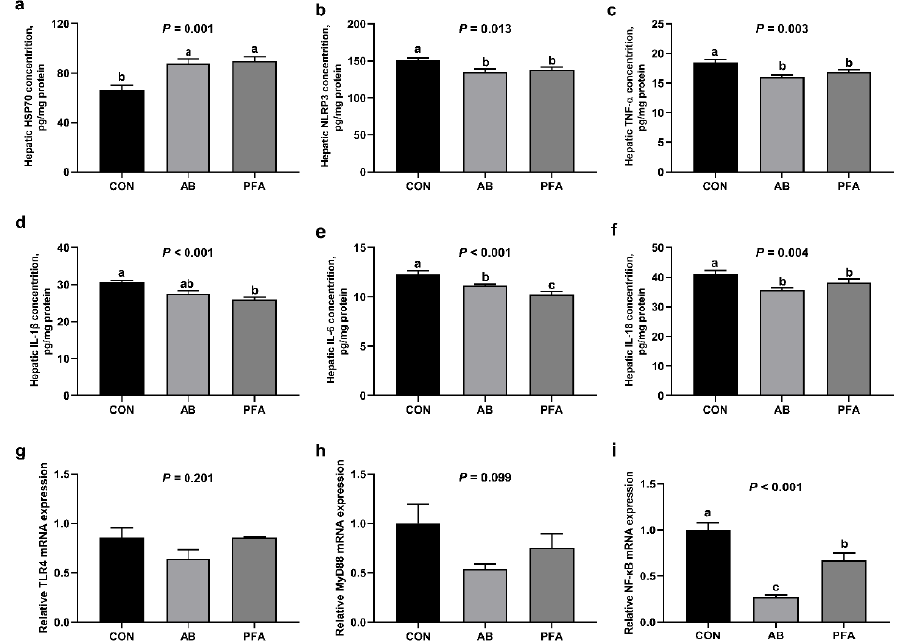
Figure 4. Effects of paraformic acid (PFA) supplementation on hepatic apoptosis indicators in broiler chickens. ( a ) HSP70, hepatic heat shock protein 70; ( b ) NLRP3, NOD-like receptor family pyrin